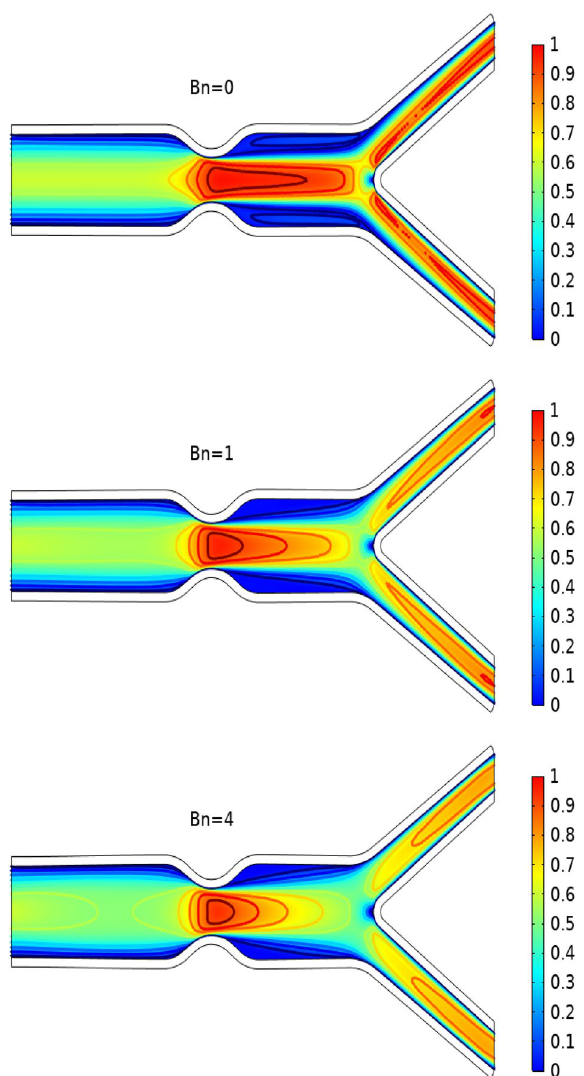
Figure 5. Velocity profile at Re = 1000 for variation of